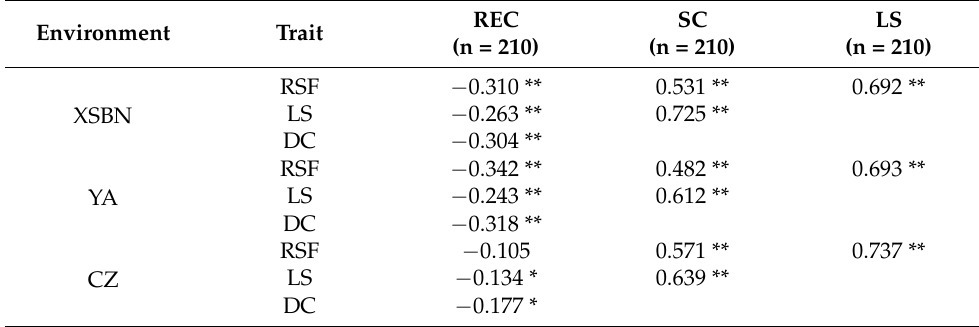
Table 2. Phenotypic correlation between the traits across the three environments. Environment